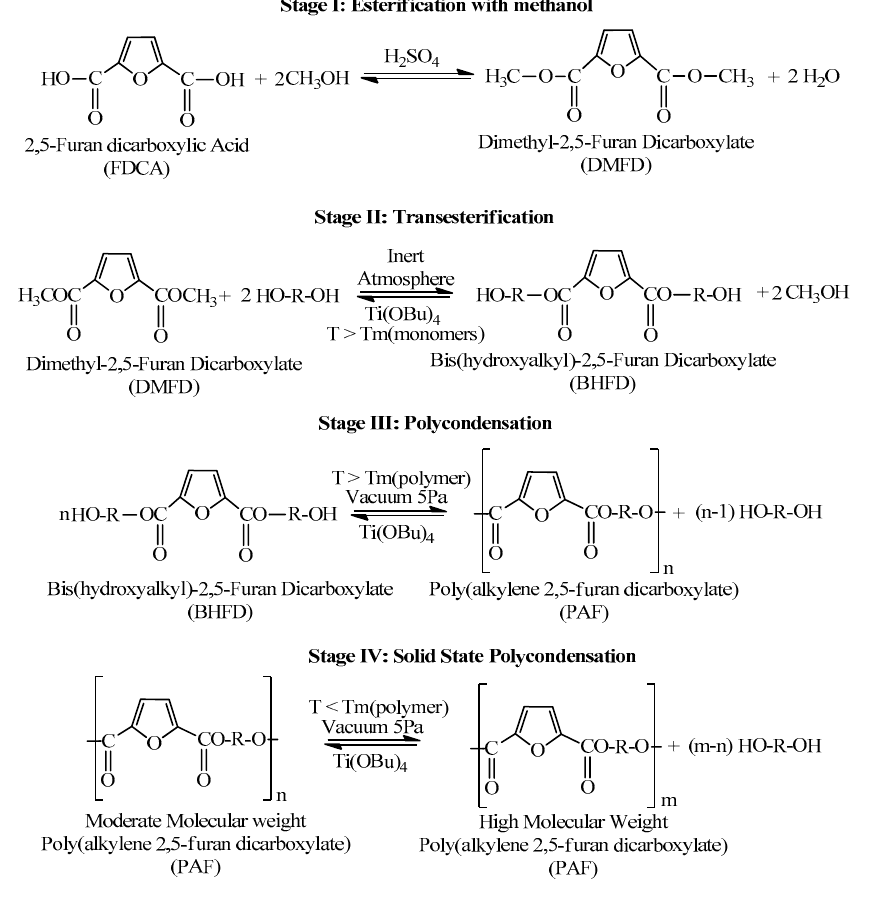
Figure 1. Reaction path for the synthesis of poly(alkylene 2,5-furan dicarboxylate)s studied in this work.